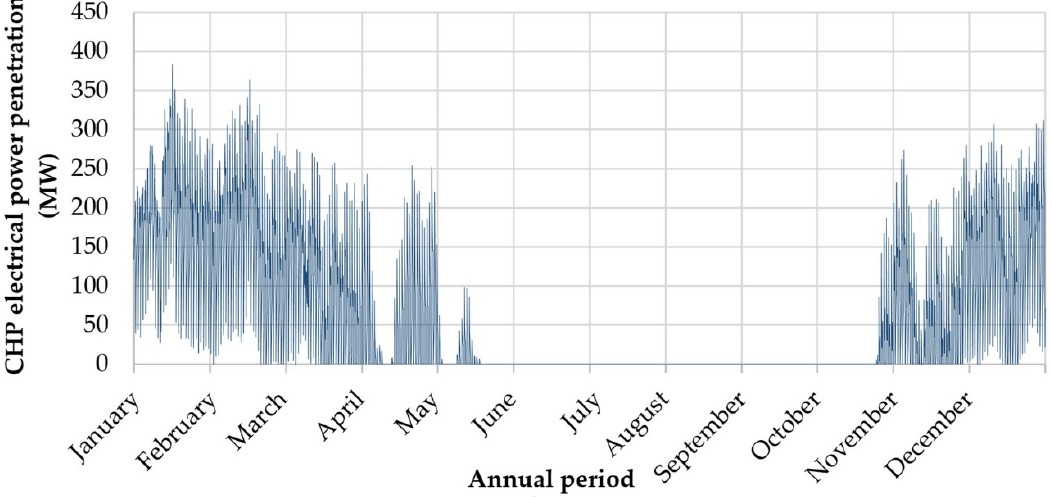
Figure 16. Annual fluctuation in the electricity production from the biogas-fired CHP plants.